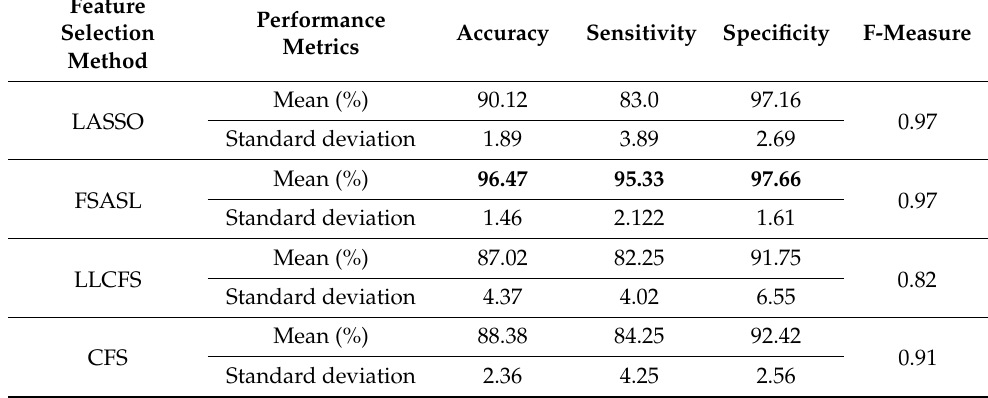
Table 6. Classification performance for HC against MCI using SL-RELM classifier on large scale brain network using different feature selection methods.